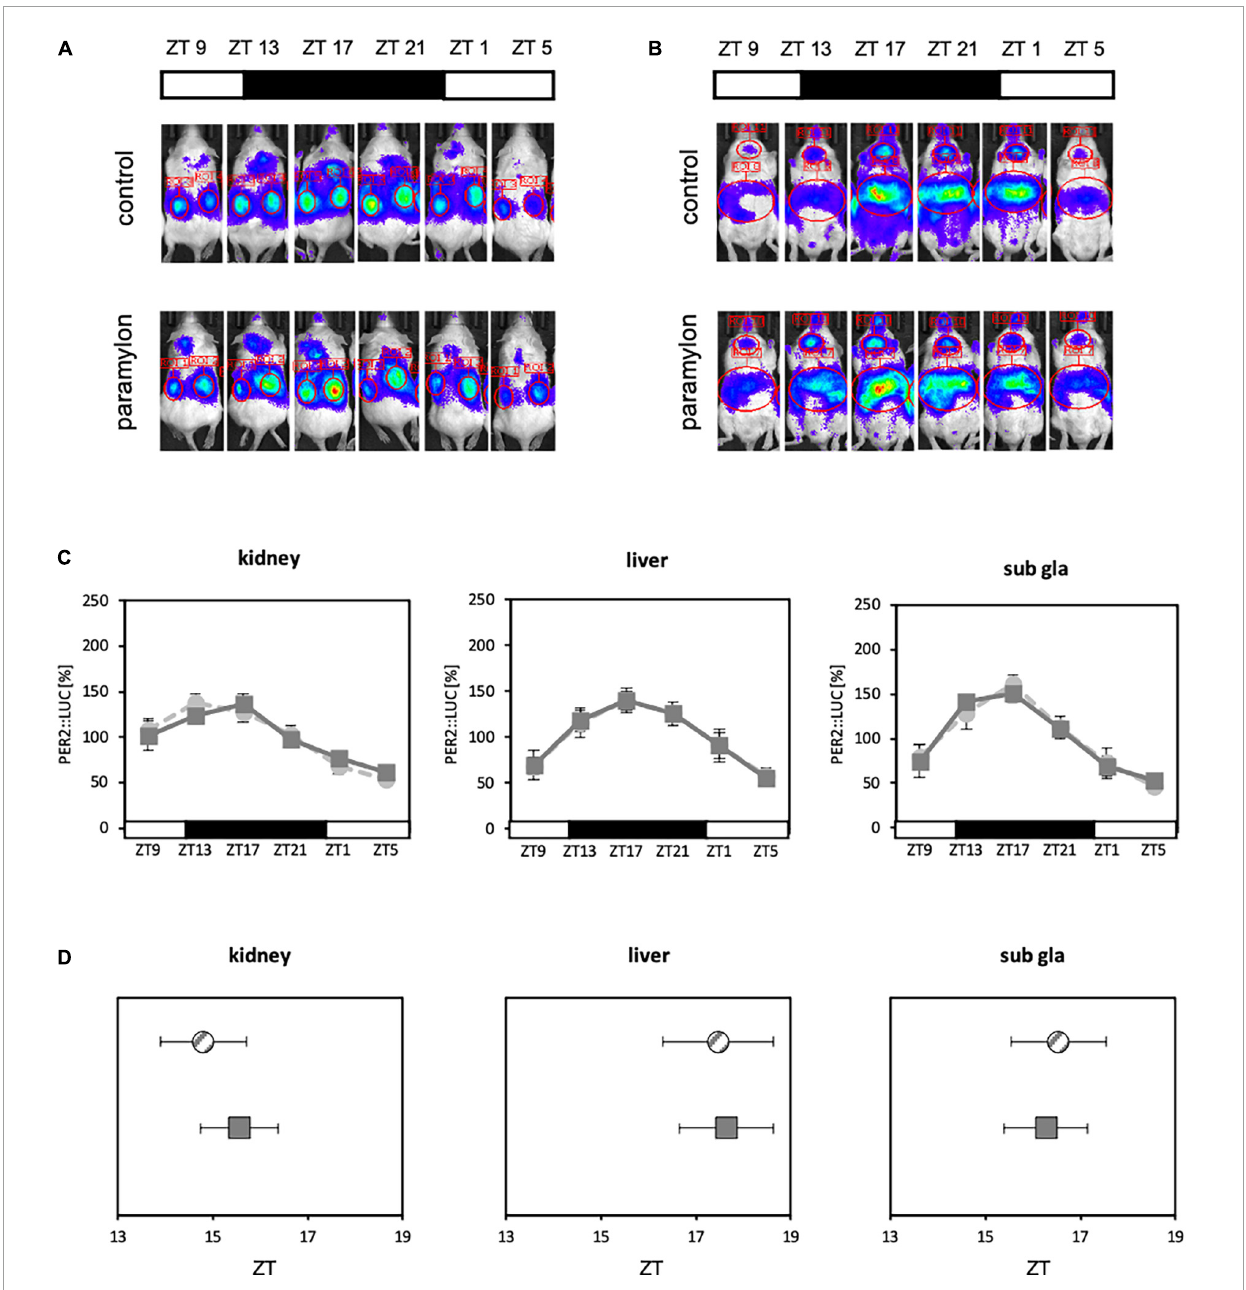
FIGURE5 Antibiotic water treatment negates the phase advancing effect of paramylon intake. (A,B) Representative images of in vivo bioluminescence imaging. (A) The luminescence observed in the kidney. (B) The luminescence observed in the liver and submandibular gland. (C) Waveforms of PER2:LUC rhythm in each tissue. Light gray dotted lines indicate the control group, and dark gray lines indicate the paramylon group. (D) Peak phases of PER2:LUC rhythm in each tissue. Gray striped dots indicate the control group, and dark gray dots indicate the paramylon group. Values are expressed as mean ± SEM. ( n = 6). (Student’s t -test)